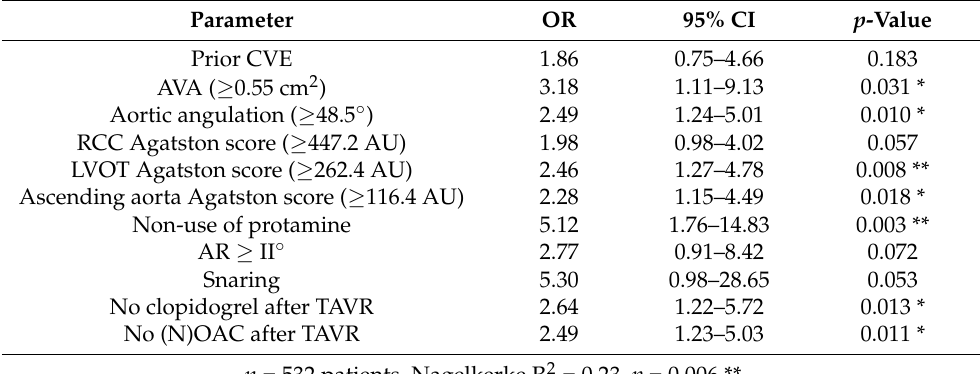
Table 4. Risk model II (pre-procedural, intra-procedural, and post-procedural parameters).